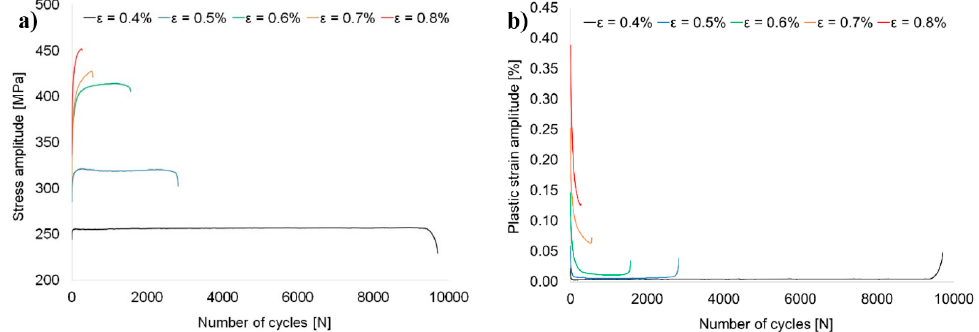
Figure 5. Variation of stress amplitude ( a ) and plastic strain amplitude ( b ) with the number of cycles. The hysteresis stress-strain loops of analyzed material for various levels of strain amplitude are